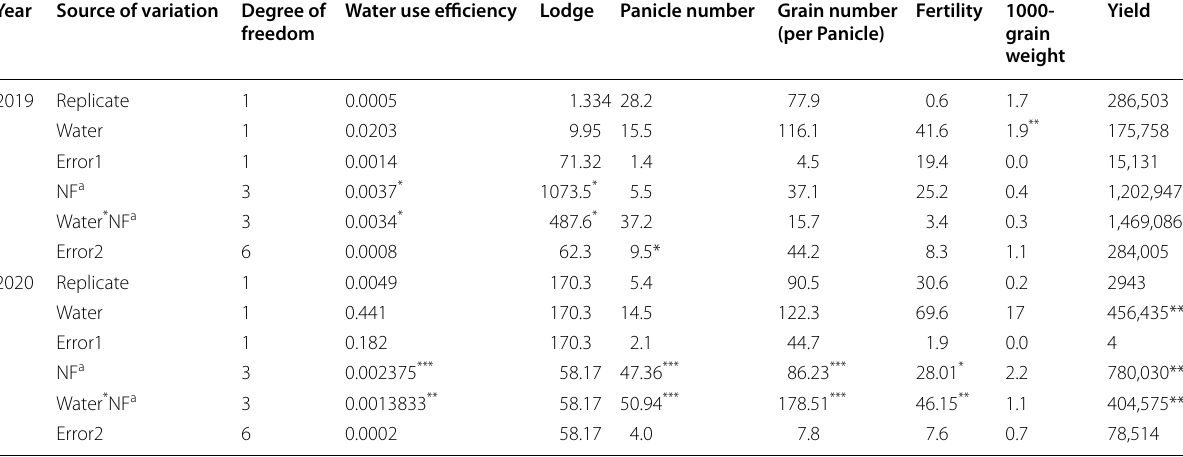
NF nitrogen fertilizer